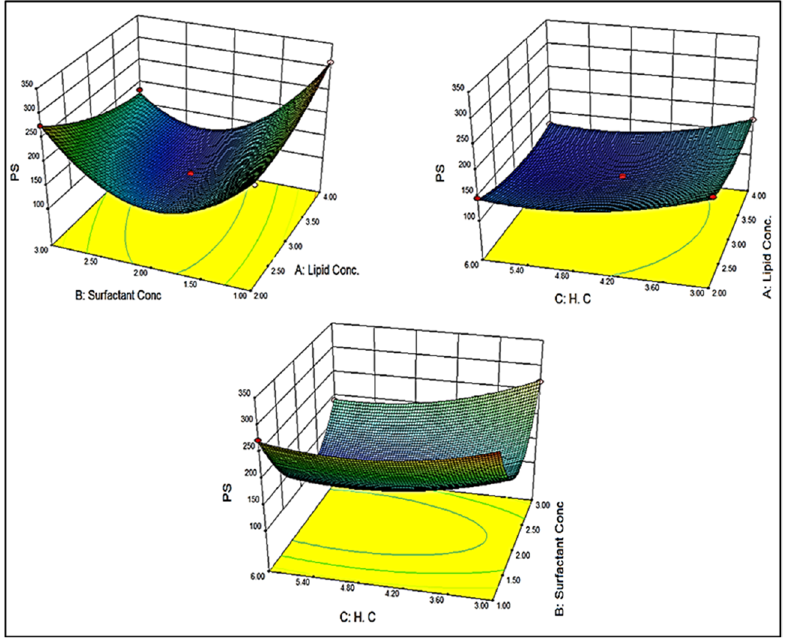
Figure 2. 3D response surface plot showing the effect of independent variables on the particle size.